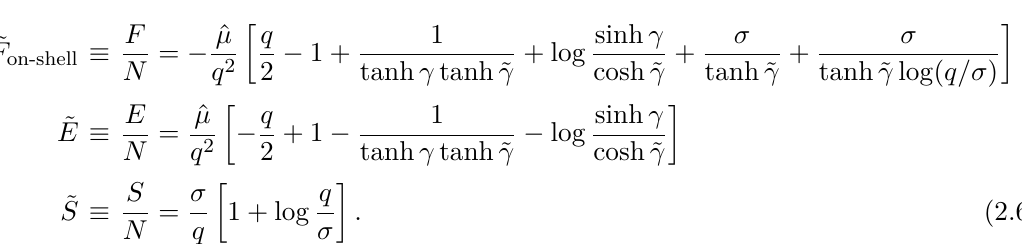
Figure 1 . On-shell free energy ˜ F on-shell = F this plot, q = 50 , J = 1 , and ˆ µ = 0 . 1 . There is a first order phase transition at the temperature T s = 0 . 000753